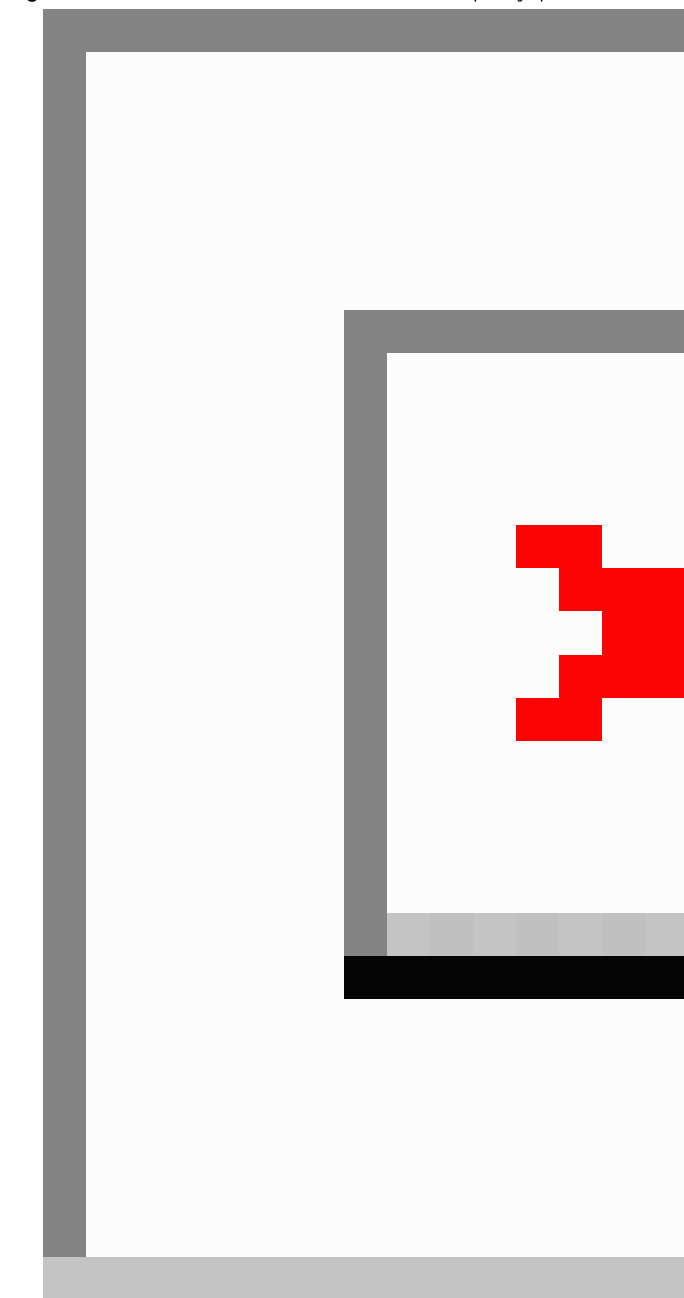
Figure 1. Screenshot of the online Food4Me food frequency